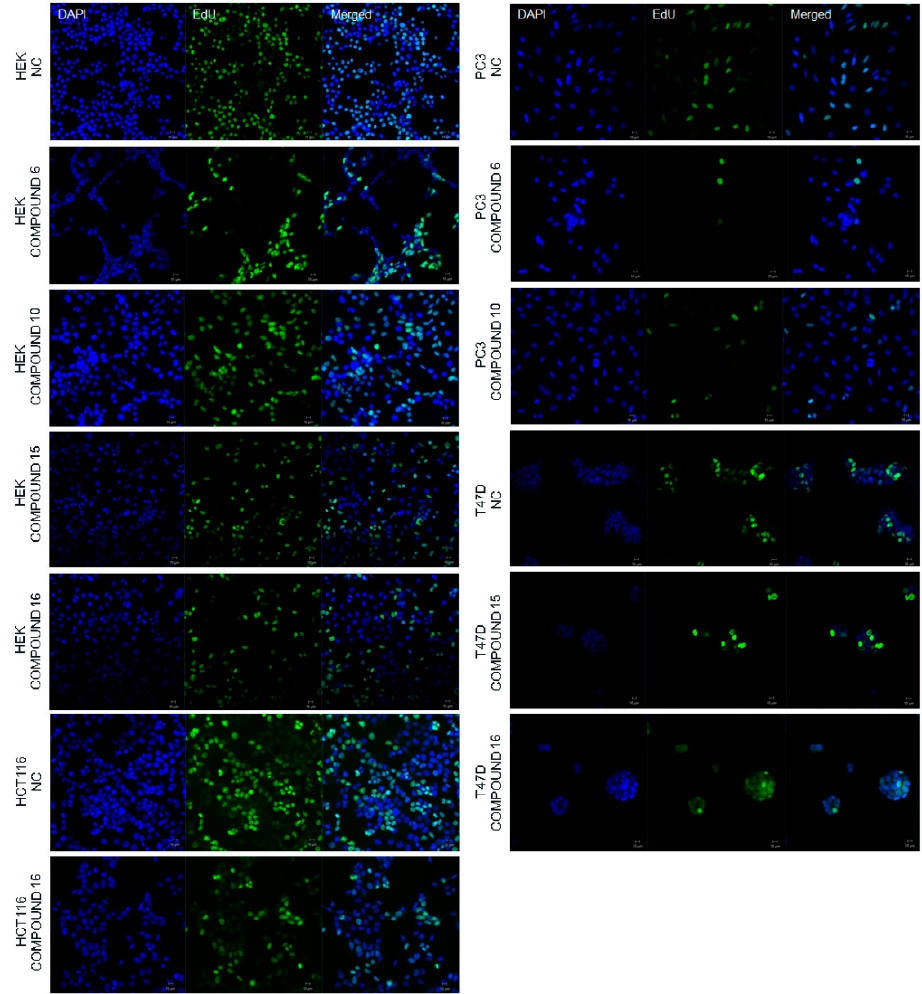
Figure 2. DAPI and EdU staining patterns of HEK293, PC-3, HCT116 and T47D cell lines. DAPI (in blue, left panel) shows all the cells, EdU shows newly synthesized DNA (in green, middle panel and merged image, right panel). As shown, when treated with compounds, the rate of DNA synthesis decreased compared to the negative control group of each cell line individually, except for the non-cancer cell line HEK293. All images captured at 20× magnification.